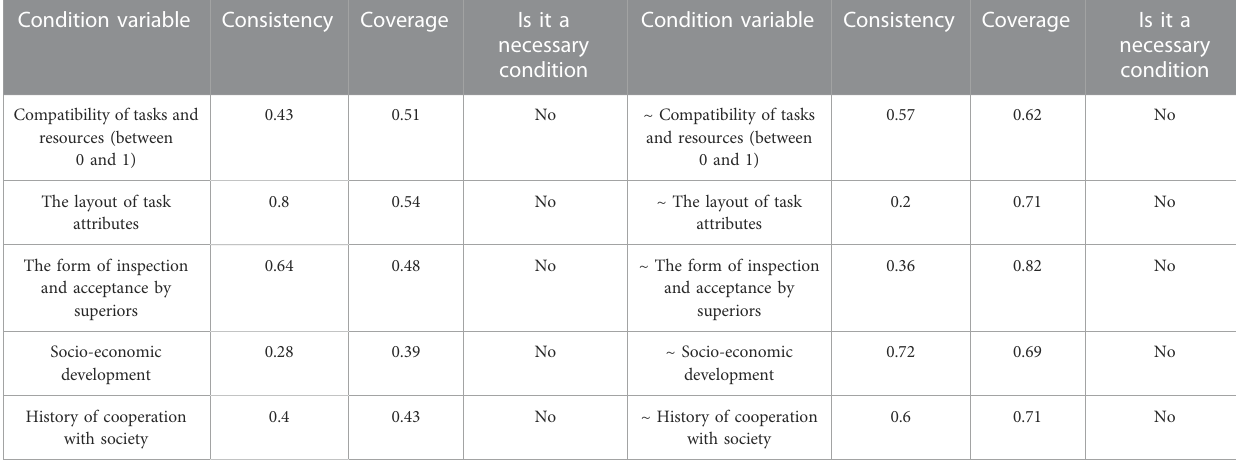
TABLE A2 Univariate Necessity Analysis with “ upward cooperation ” (cooperating with the middle-level government) as the dependent variable. Condition